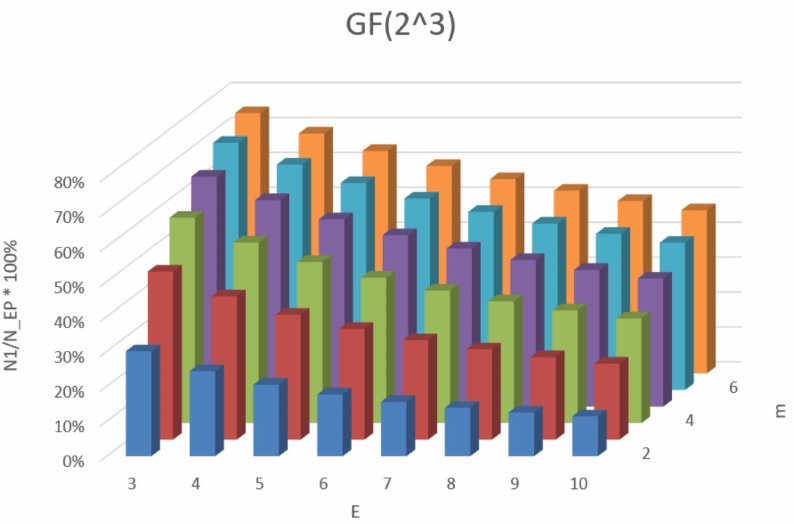
Figure 4. Contribution to the total complexity estimate N EP for a group of polynomials over GF ( 2 3 )